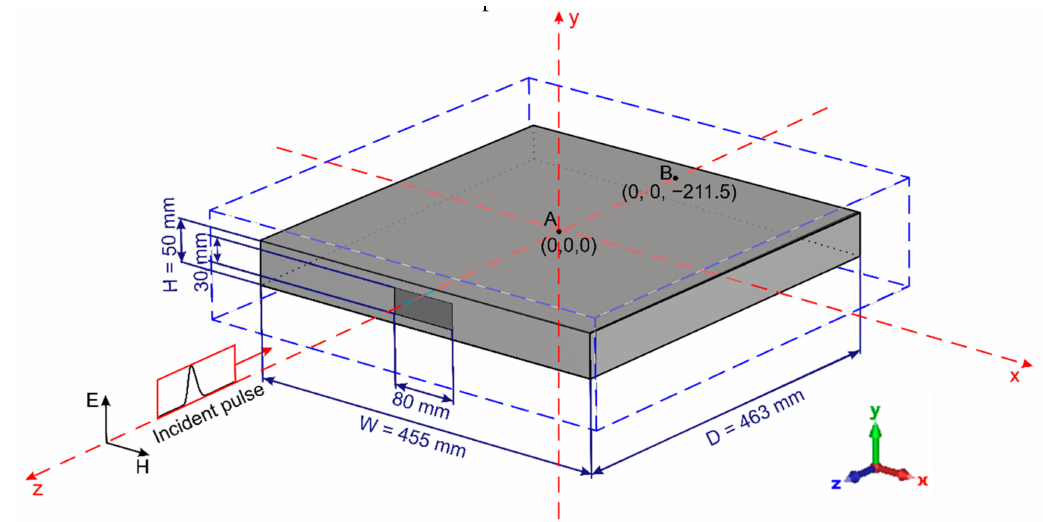
Figure 1. The geometry of the enclosure with aperture in the rectangular coordinate system. The computation area is marked in blue dashed lines. The electric field strength vector E is directed in the +y direction. The magnetic strength vector H is directed in the +x direction. Point A is the center of the enclosure. Point B marks the place where the substantial EM wave interference took place (see Section